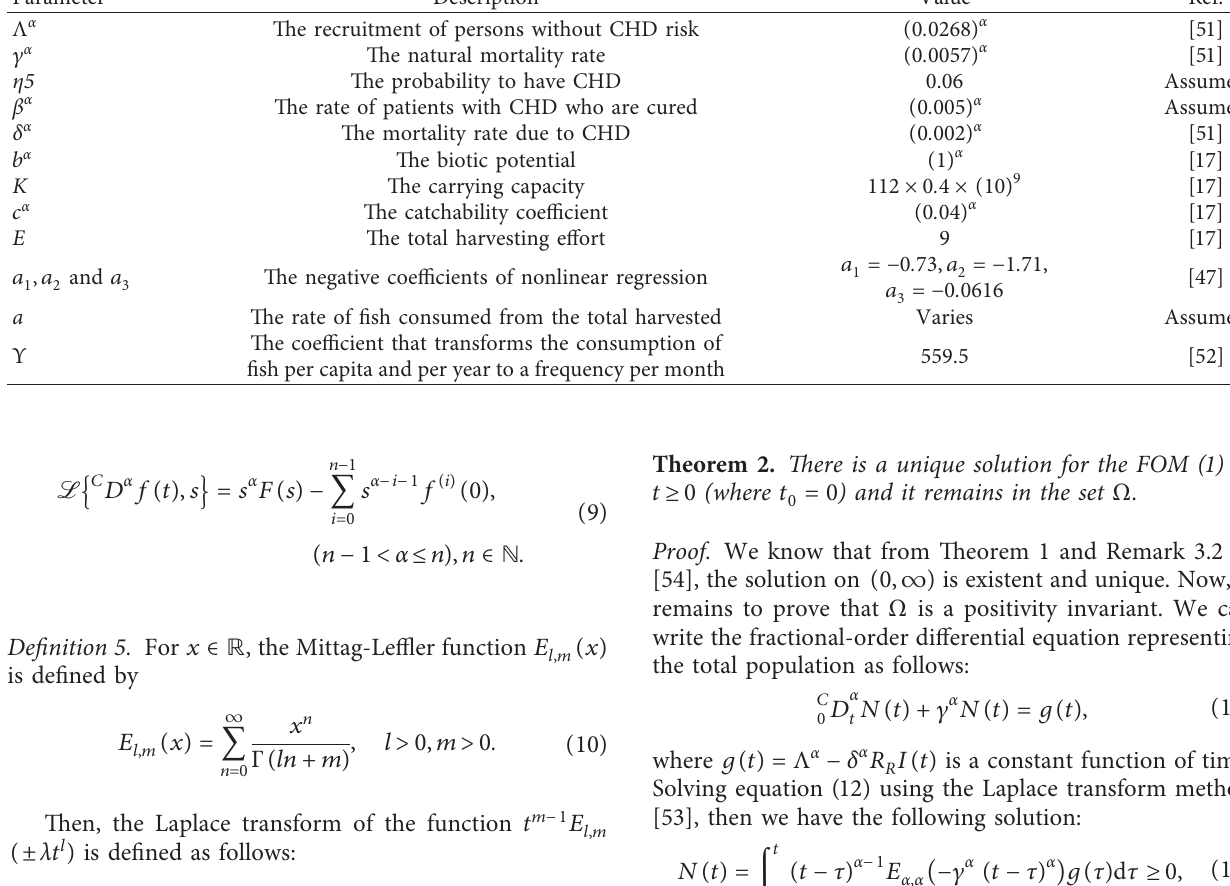
a � 1 for different values of α R with